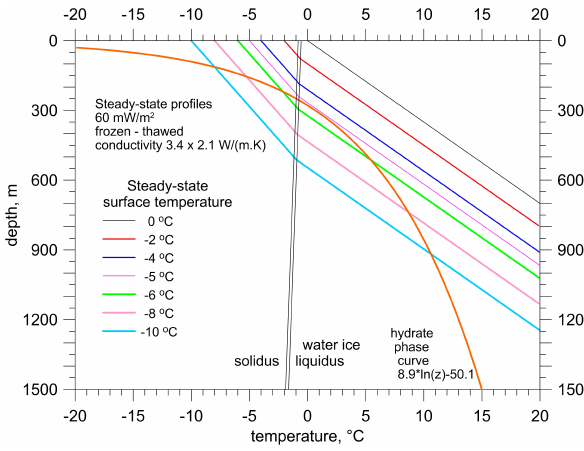
Fig. 3. Steady-state profiles for Mallik wells on Richards Island area geothermal model. Conductivity of the frozen and thawed rock is assumed to be 3.4 and 2.1Wm − 1 K − 1 , respectively. Note: the figure shows that GH is stable only for steady state surface temper- atures < − 5 ◦ C for the terrestrial heat flow and thermal properties of the Beaufort Mackenzie